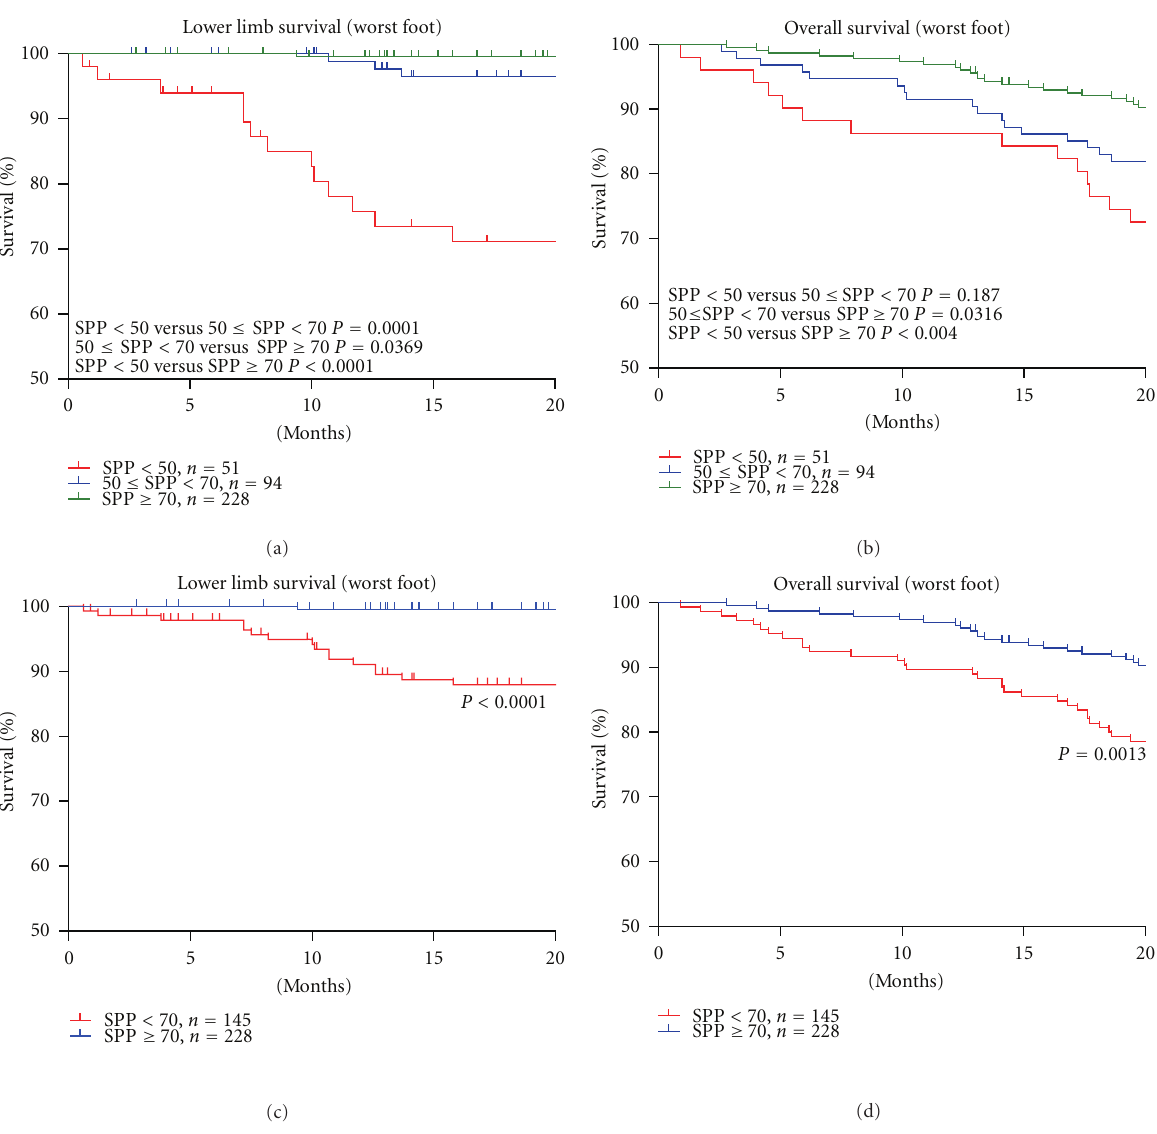
Figure 3: Lower limb survival and overall survival based on the worst foot SPP. Patients were categorized according to the worst foot SPP value: < 50, 50 ≤ SPP < 70, SPP ≥ 70. There were no major di ff erences in lower limb survival and overall survival between worst foot SPP and average of SPP. We used average of SPP for risk classification